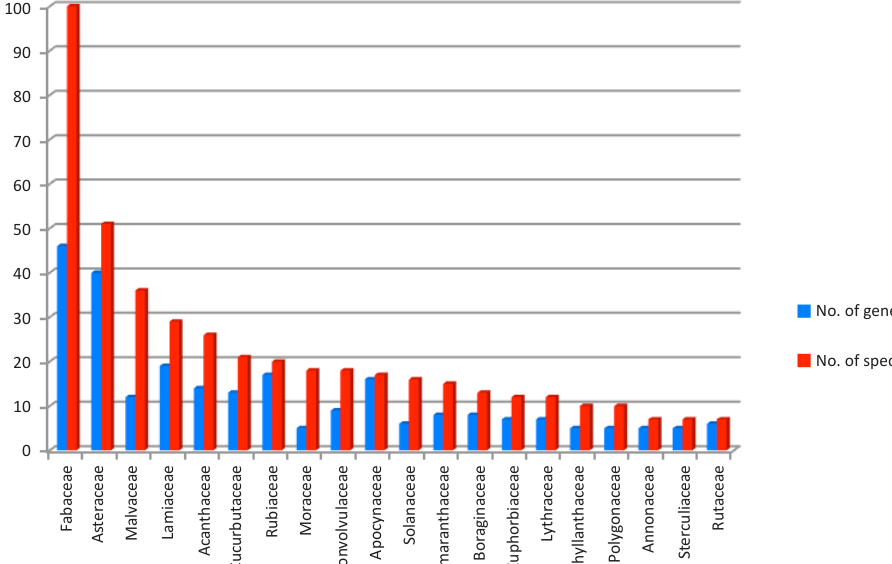
Figure 4. Largest families in dicots